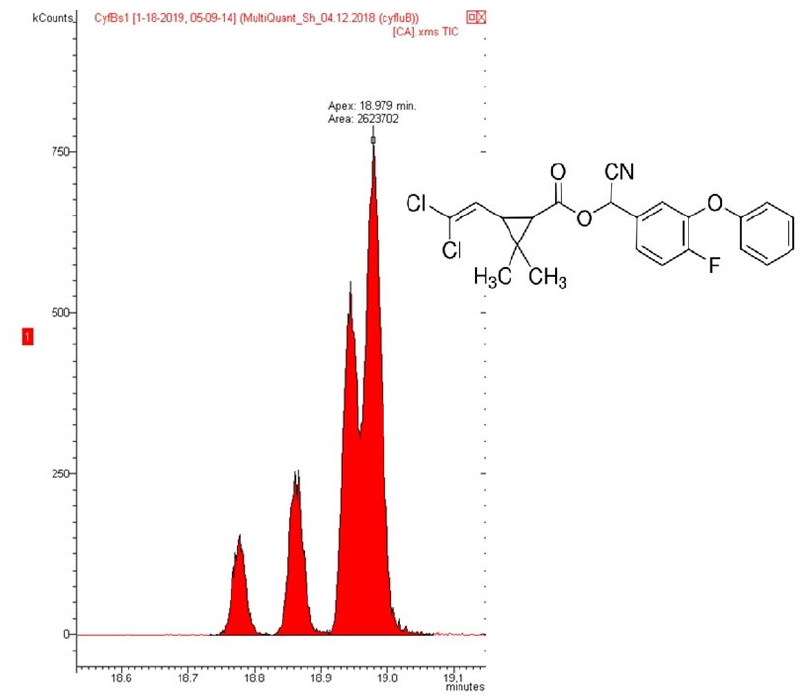
Figure 3. Determination of beta ‐ cyfluthrin residues in the surface of olive leaves using GC ‐ MS/MS system.